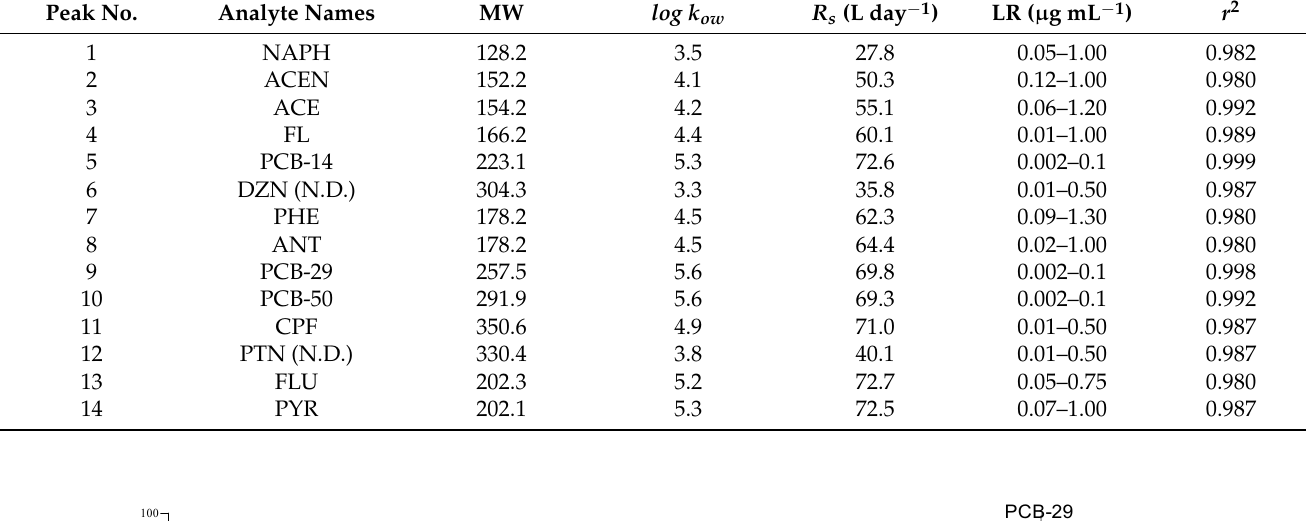
Table 2. R s estimated at 24 days of sampling deployment. Molecular weight (MW), Linear regression (LR), correlation ( r 2 ). N.D., Not detected using SPMDs in SIM mode analysis.